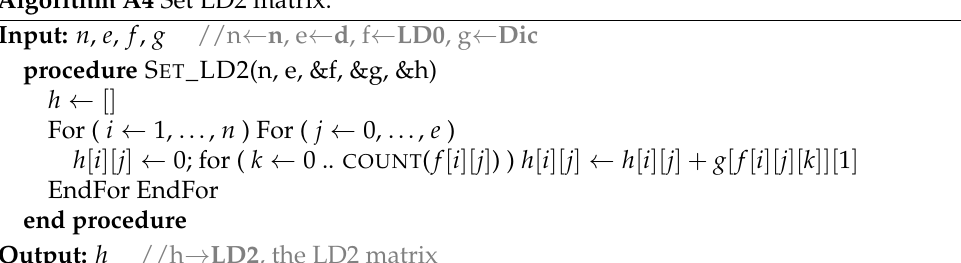
Algorithm A4 Set LD2